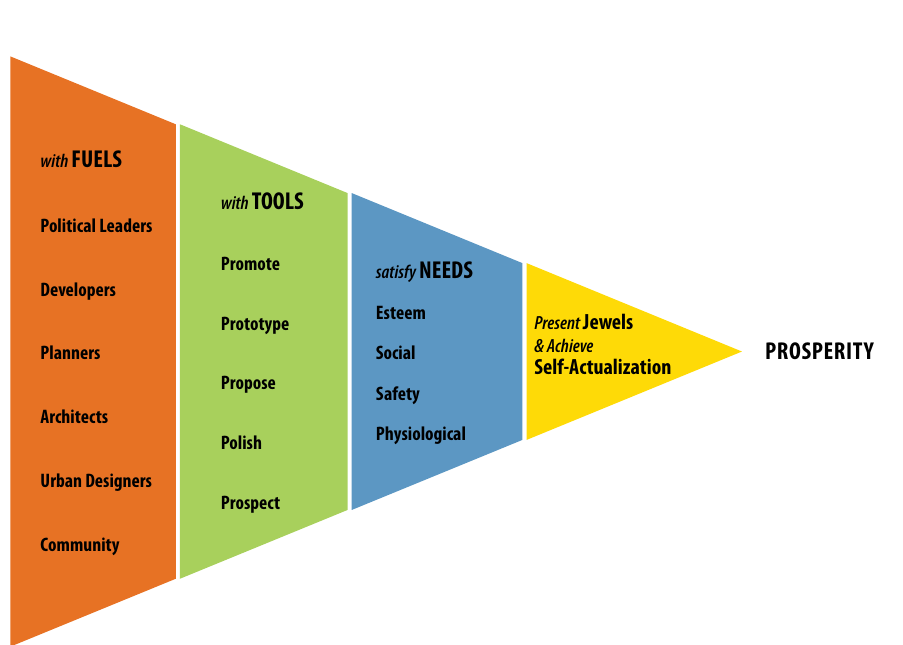
Fig. 5. Prosperity pyramid: a sideways